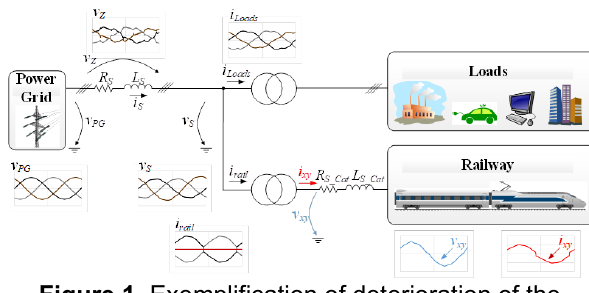
Figure 1. Exemplification of deterioration of the power grid voltages.